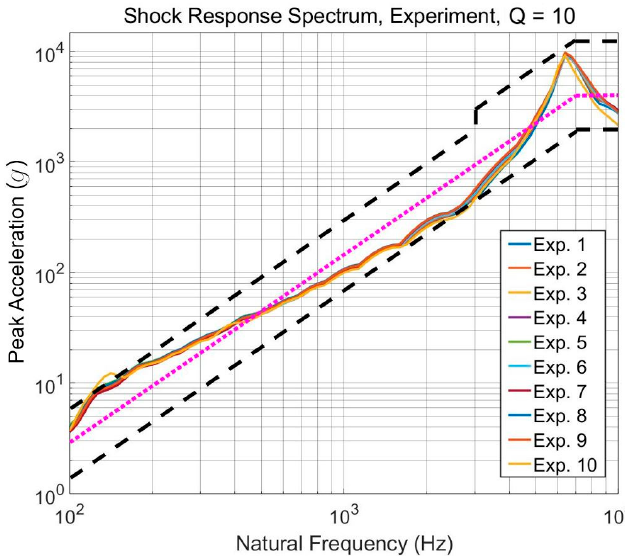
Figure 20. Repeatability test results of pyroshock simulator.